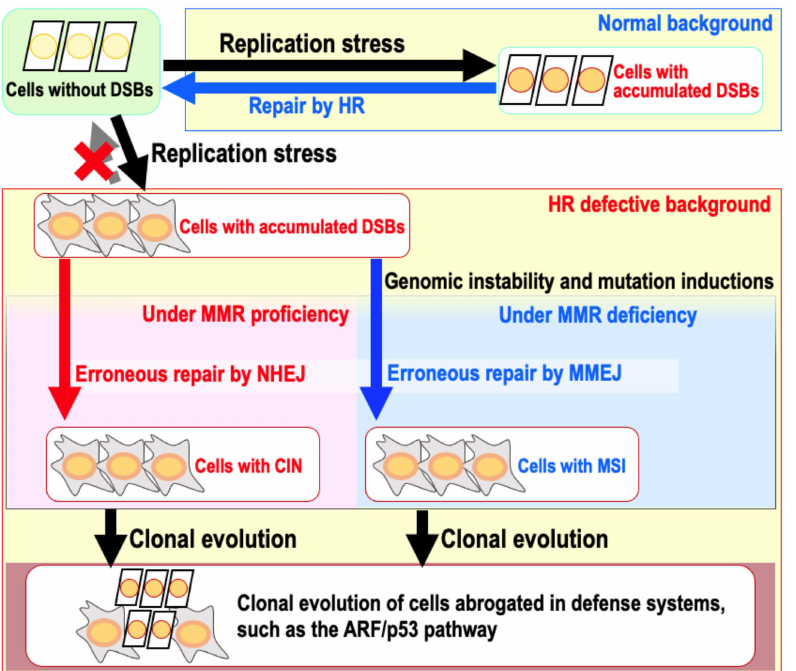
Figure 1. Models for mutagenesis and clonal evolution associated with CIN/MSI induction. Replica- tion stress-associated DSBs are generally repaired by HR under normal conditions. In HR defective backgrounds, these DSBs accumulate and lead to genomic instability through erroneous DSB re- pair by NHEJ and MMEJ, resulting in CIN and MSI, respectively. Since genomic destabilization is associated with mutagenesis, this further leads to clonal